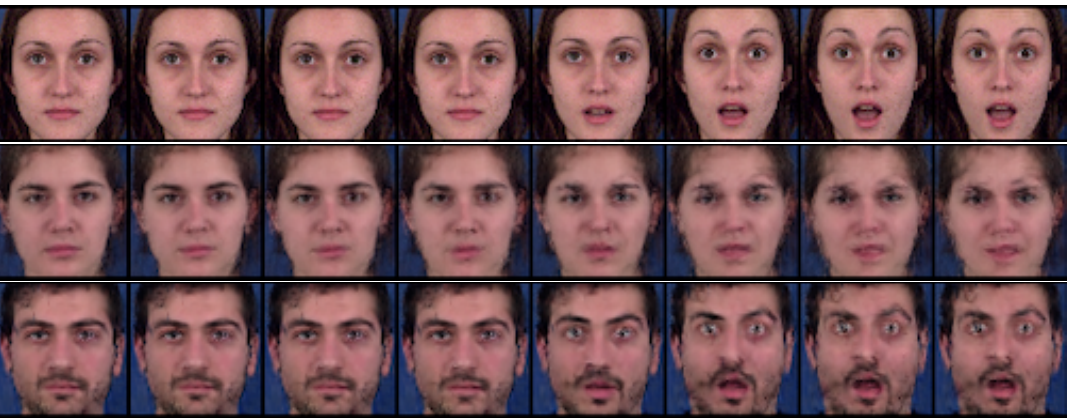
Figure 12. Example of randomly sampled generation on the MUG dataset. We fixed the dynamic variables and randomly sampled the static variable. The top, middle, and bottom rows denote the input video and the results using DSVAE and the proposed method,